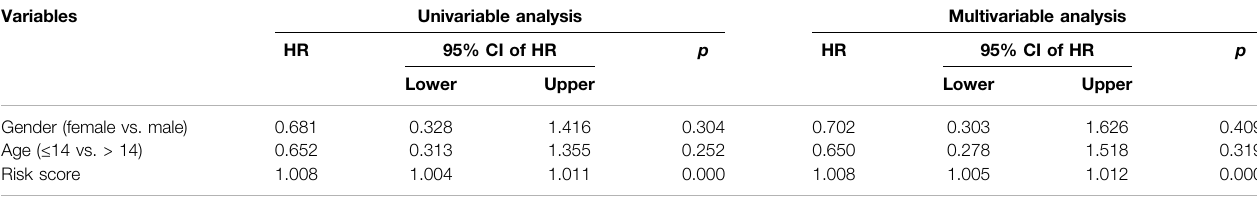
TABLE 2 | Univariable and multivariable analysis of the four-SLC prognostic signature and clinical factors in the TCGA cohort. Variables